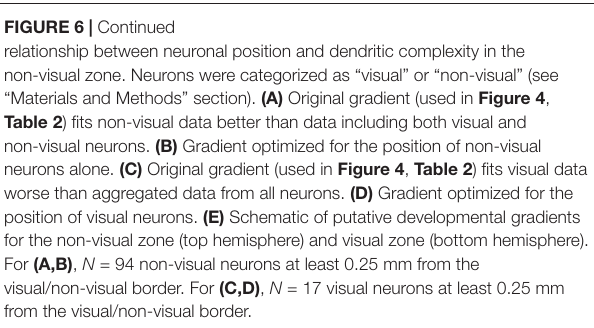
FIGURE 6 | Continued relationship between neuronal position and dendritic complexity in the non-visual zone. Neurons were categorized as “visual” or “non-visual” (see “Materials and Methods” section). (A) Original gradient (used in Figure 4 , Table 2 ) fits non-visual data better than data including both visual and non-visual neurons. (B) Gradient optimized for the position of non-visual neurons alone. (C) Original gradient (used in Figure 4 , Table 2 ) fits visual data worse than aggregated data from all neurons. (D) Gradient optimized for the position of visual neurons. (E) Schematic of putative developmental gradients for the non-visual zone (top hemisphere) and visual zone (bottom hemisphere). For (A,B) , N = 94 non-visual neurons at least 0.25 mm from the visual/non-visual border. For (C,D) , N = 17 visual neurons at least 0.25 mm from the visual/non-visual